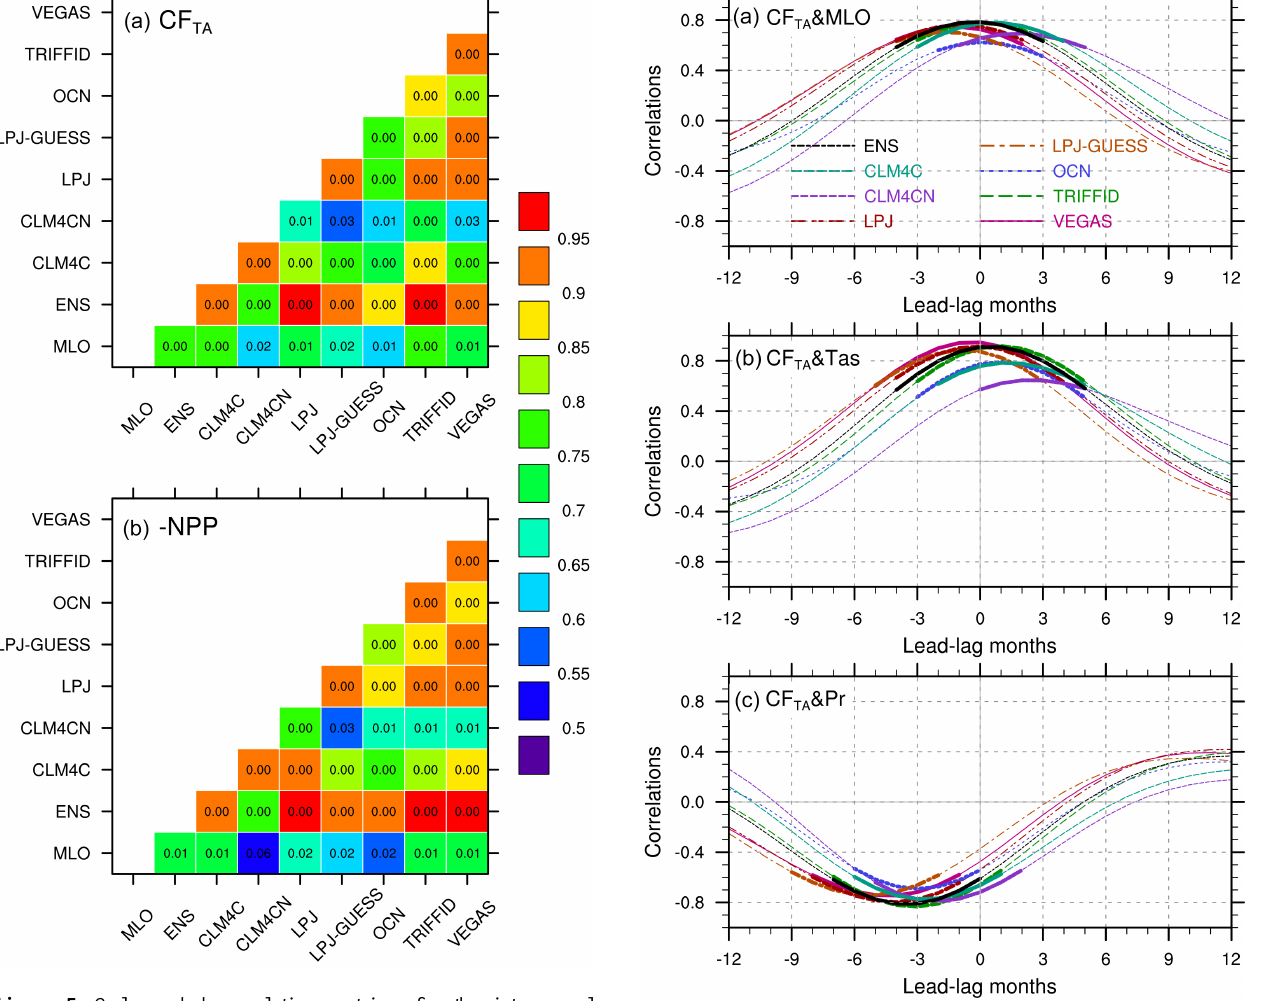
Figure 6. The cross-correlations of the simulated tropical CF TA anomalies with Mauna Loa CGR, tropical near-surface temperature, and precipitation over land. The negative months on the horizontal axis indicate that the anomalies in CF TA lag behind. Bold lines in- dicate correlation above 95% significance ( p ≤ 0 .